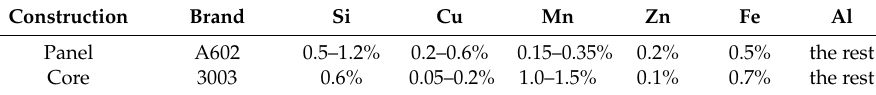
Table 1. The material compositions of panels and core.